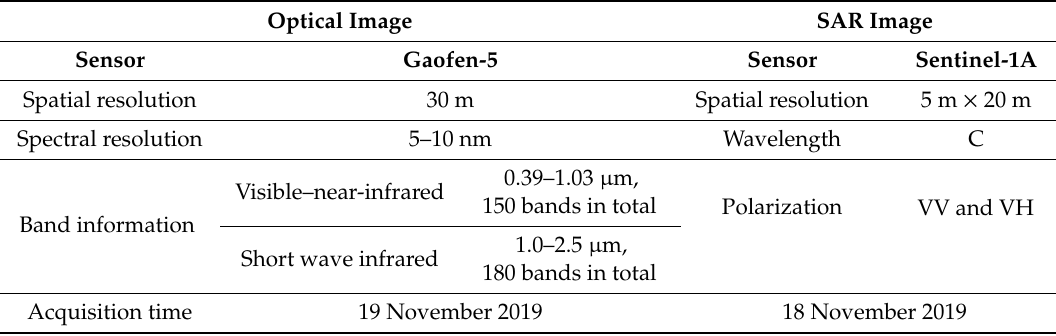
Table 1. Characteristics of optical and synthetic aperture radar (SAR) images in this study.